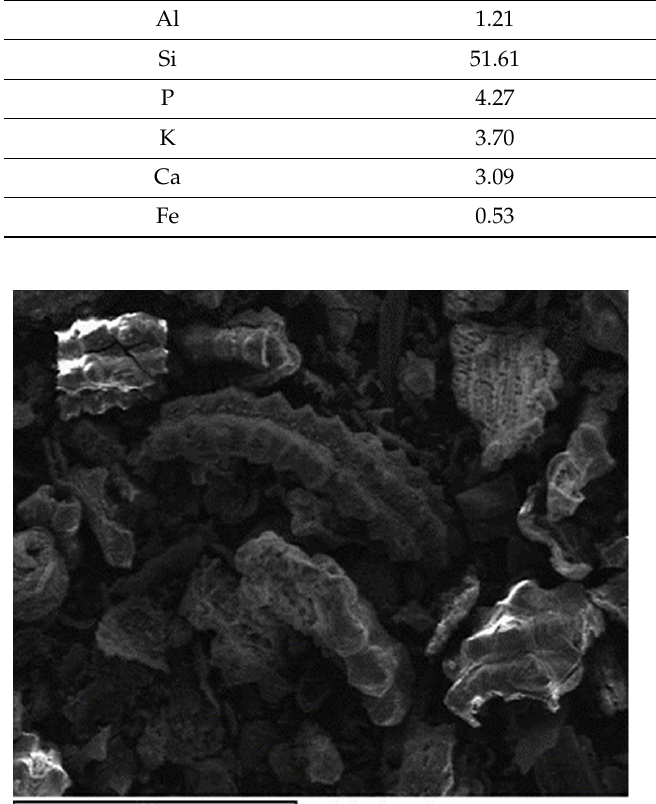
Figure 2. SEM Image of RHA.